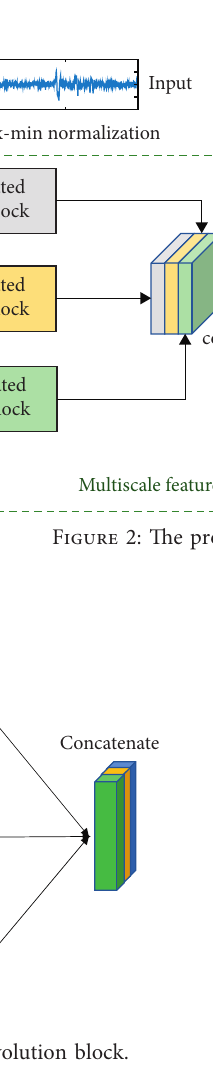
Figure 1: Different dilation rates in dilated convolution: (a) dilation rate � 1, (b) dilation rate � 2, and (c) dilation rate � 3.